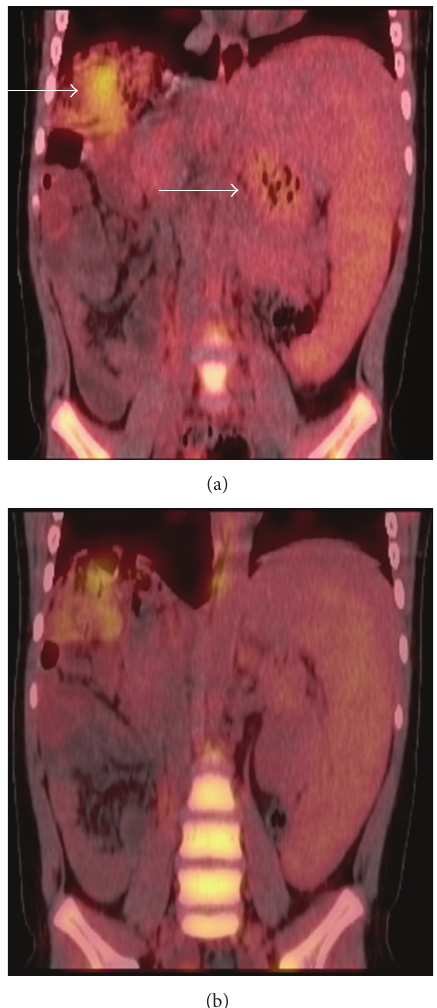
Figure 1: A PET scan identified abnormal hypermetabolic areas localized in spleen, transplanted liver, and bone marrow secondary to an inflammatory process (white